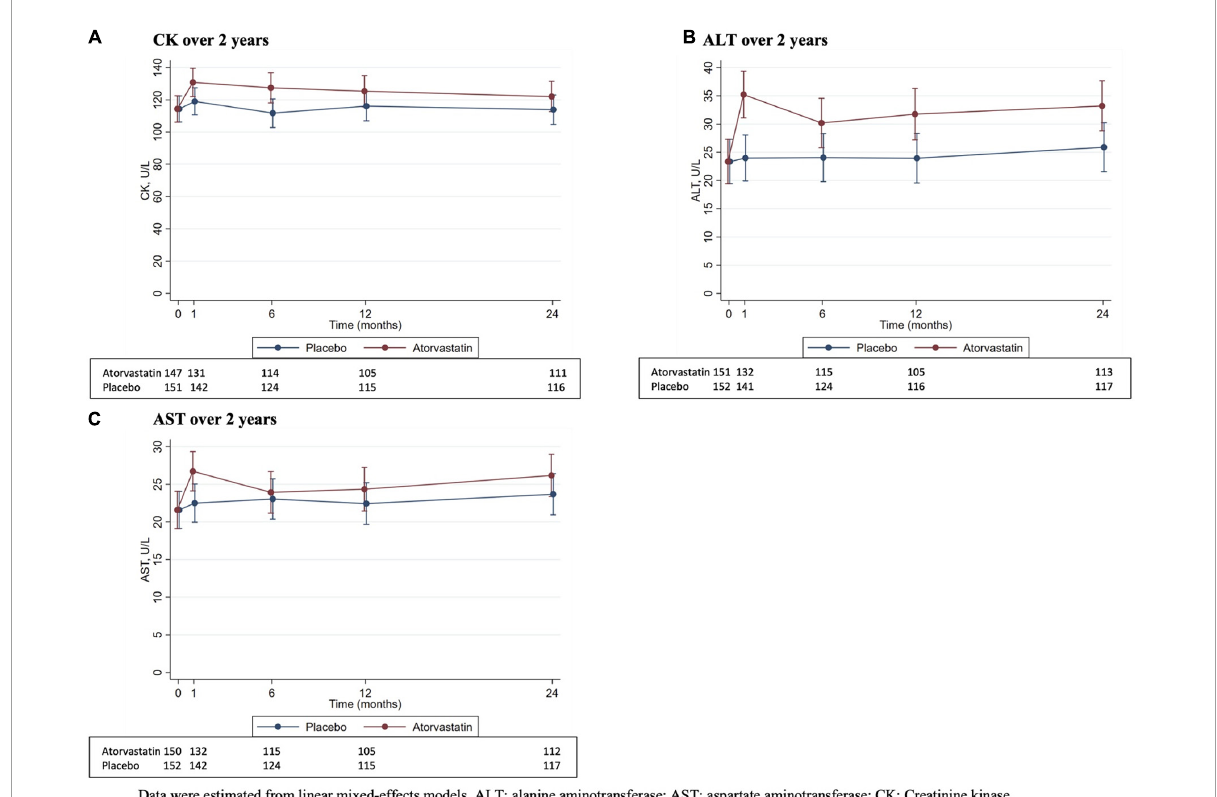
FIGURE1 Muscle biochemistry biomarkers (mean and 95% confidence interval) at each time point over 2 years. Data were estimated from linear mixed-effects models. ALT, alanine aminotransferase; CK, creatinine